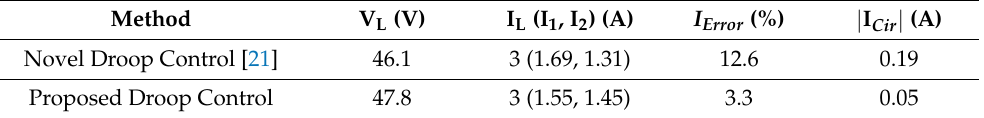
Table 10. Comparison of experimental results of different methods considering variation in load with different cable resistances.